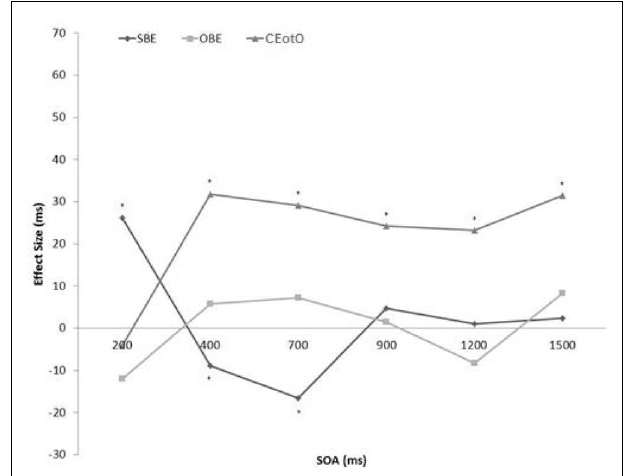
FIGURE 3 | Effect sizes (ms) of the space-based (valid versus invalid), object-based (SO versus DO), and cued end of the object (cued versus non-cued) comparison in the High Uncertainty condition from SOA 200 to SOA 1500 (significant effects are marked with an asterisk).